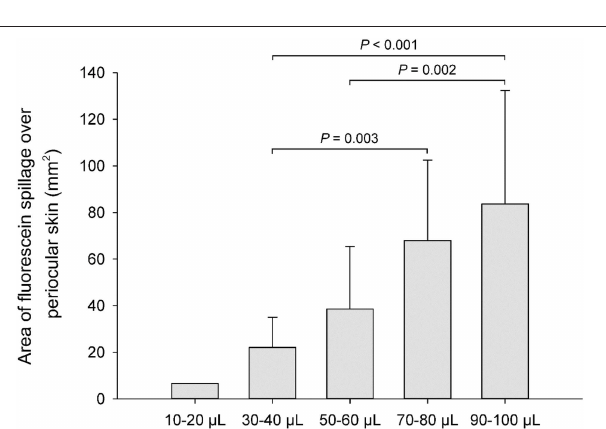
FIGURE 5 | Bar chart depicting the mean area ( + SD) of periocular spillage of 0.1% fluorescein solution, instilled at various volumes (10–100 µ l) in 8 Beagle dogs ( n = 16